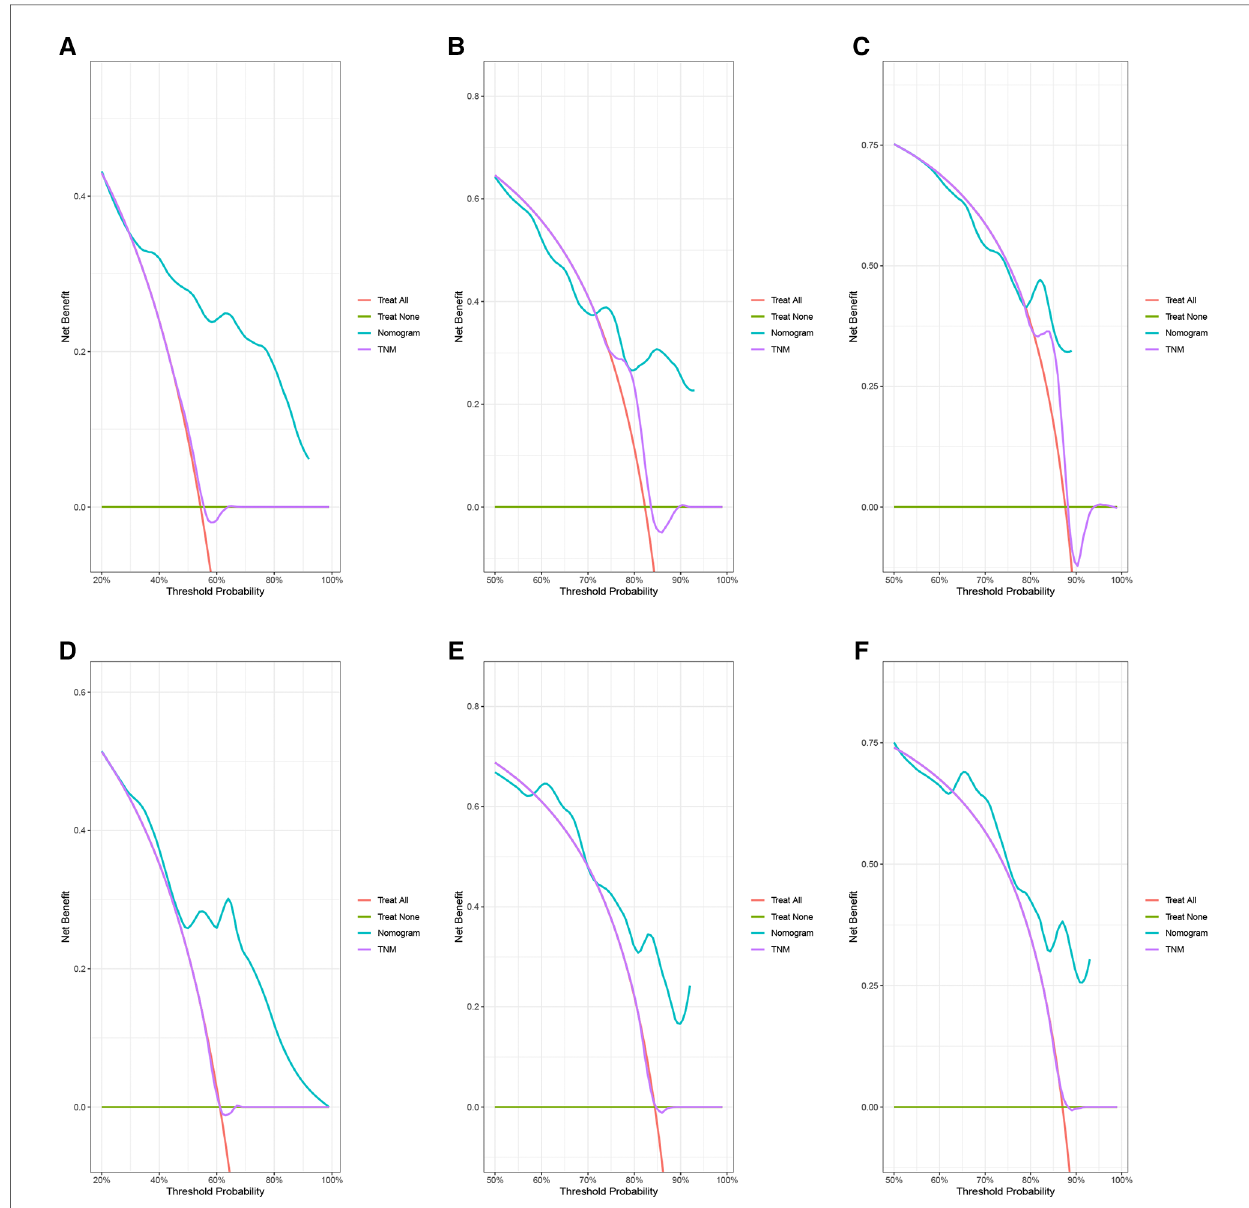
FIGURE 7 DCA curves of the 1-, 3-, and 5-year CSS of NEPC patients. 1-year ( A ), 3-year ( B ), 5-year ( C ) CSS in training group; 1-year ( D ), 3-year ( E ), 5-year ( F ) CSS in validation